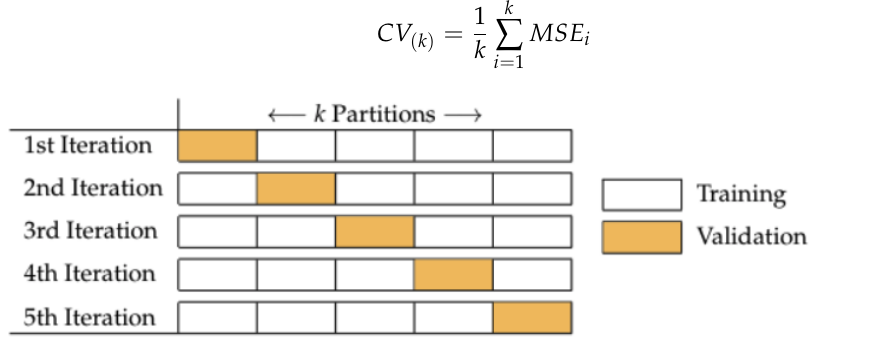
Figure 1. k -fold cross